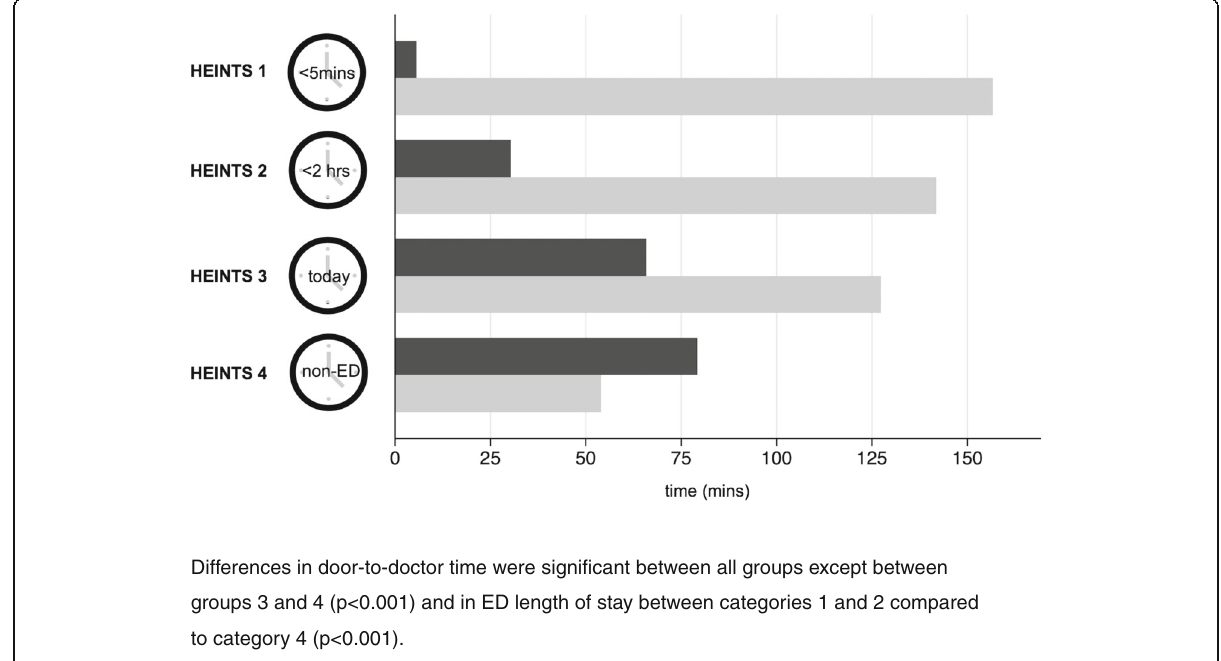
Fig. 4 Means of door-to-doctor time (dark grey) and ED length of stay (light grey) in HEINTS triage categories 1 to 4 Differences in door-to- doctor time were significant between all groups except between groups 3 and 4 ( p < 0.001) and in ED length of stay between categories 1 and 2